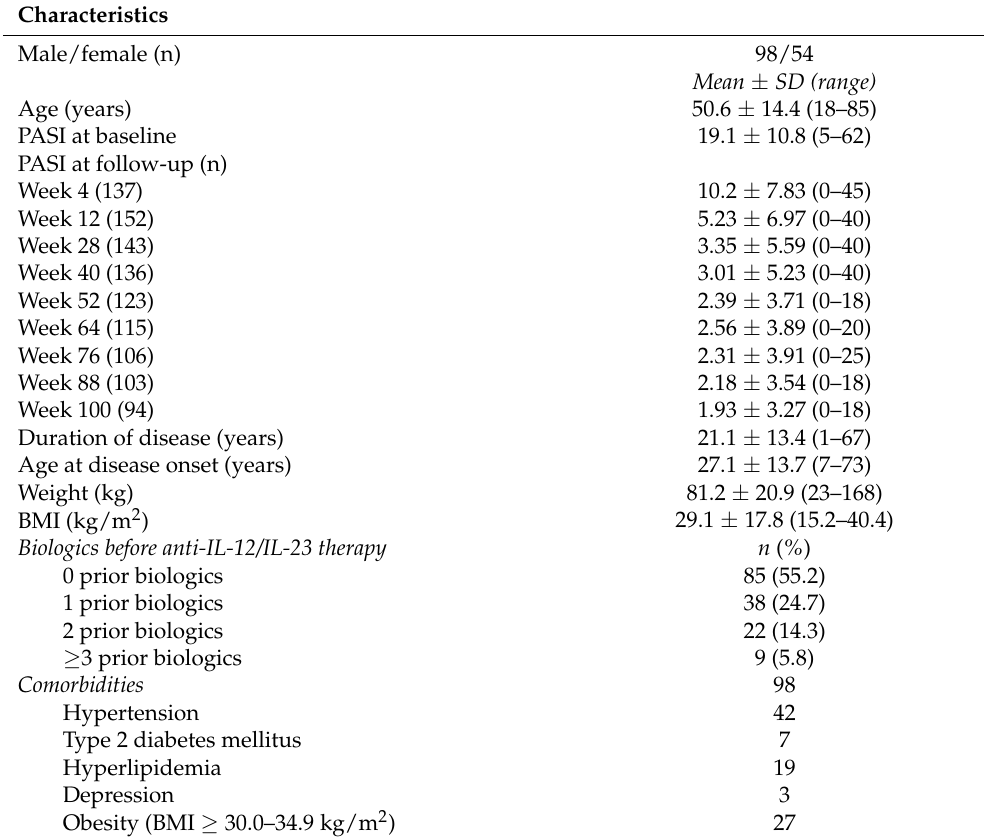
Table 1. Demographic and disease characteristics of patients ( n